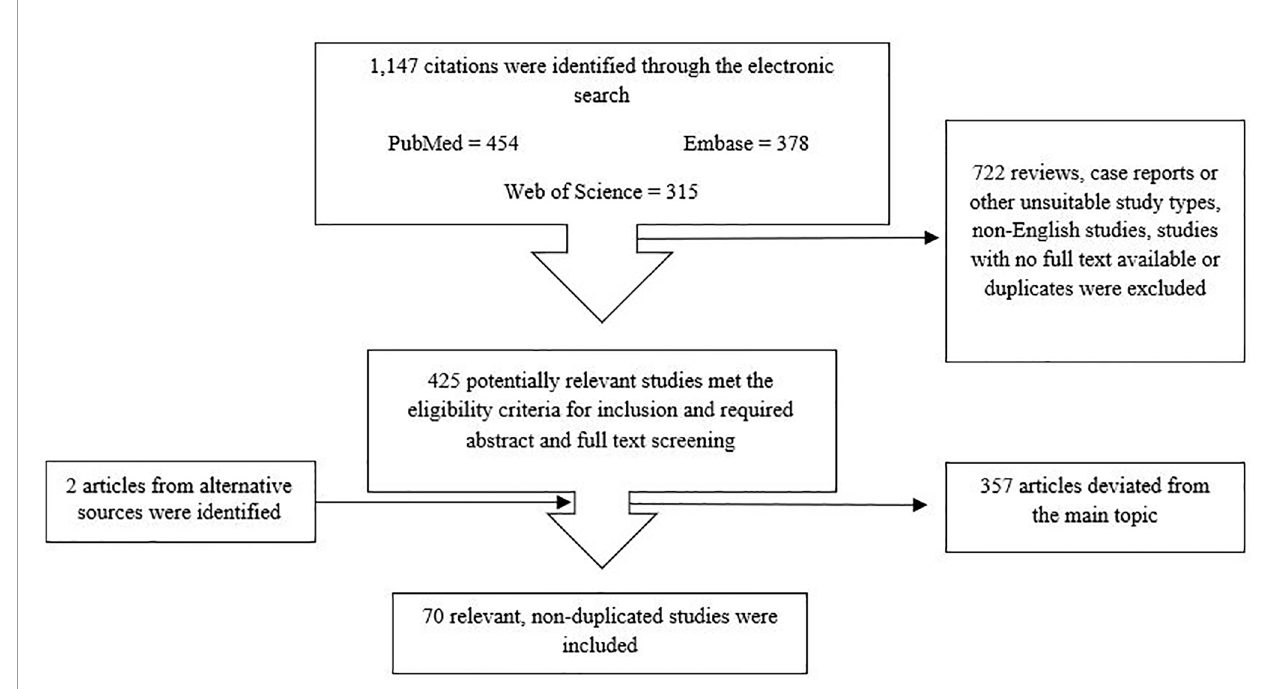
FIGURE 1 | Flowchart for article screening and selection.